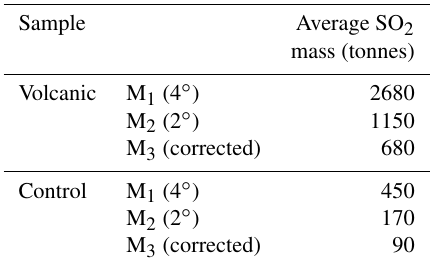
Table 3. Average SO 2 column amounts (tonnes) for volcanic and control